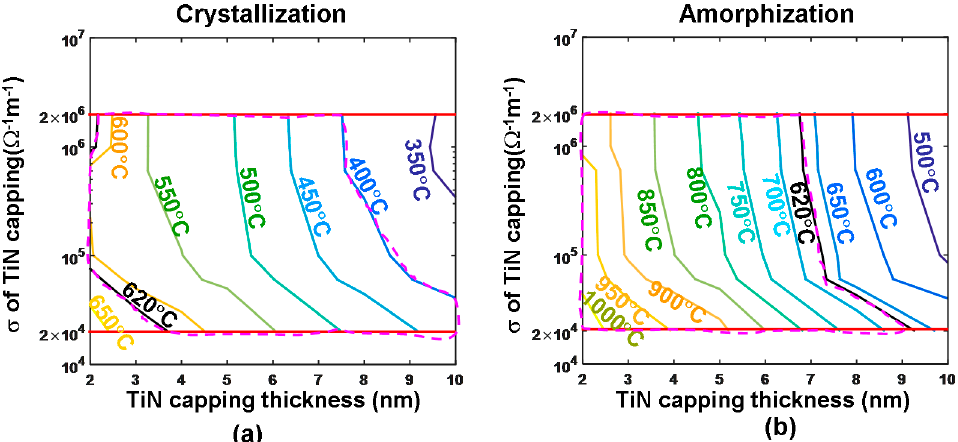
Figure 10. Maximum temperature inside the GST layer as a function of the electrical conductivities and the thickness of the TiN capping layer for ( a ) crystallization by a 5.5 V of 180 ns and ( b ) amorphization by a 6.5 V of 150 ns. The investigated electrical conductivity range of the TiN capping layer is bounded by two red lines, while the resulting optimized regions are encompassed by the violet dashes. Reprinted with permission from [36]. Copyright Springer, 2018.